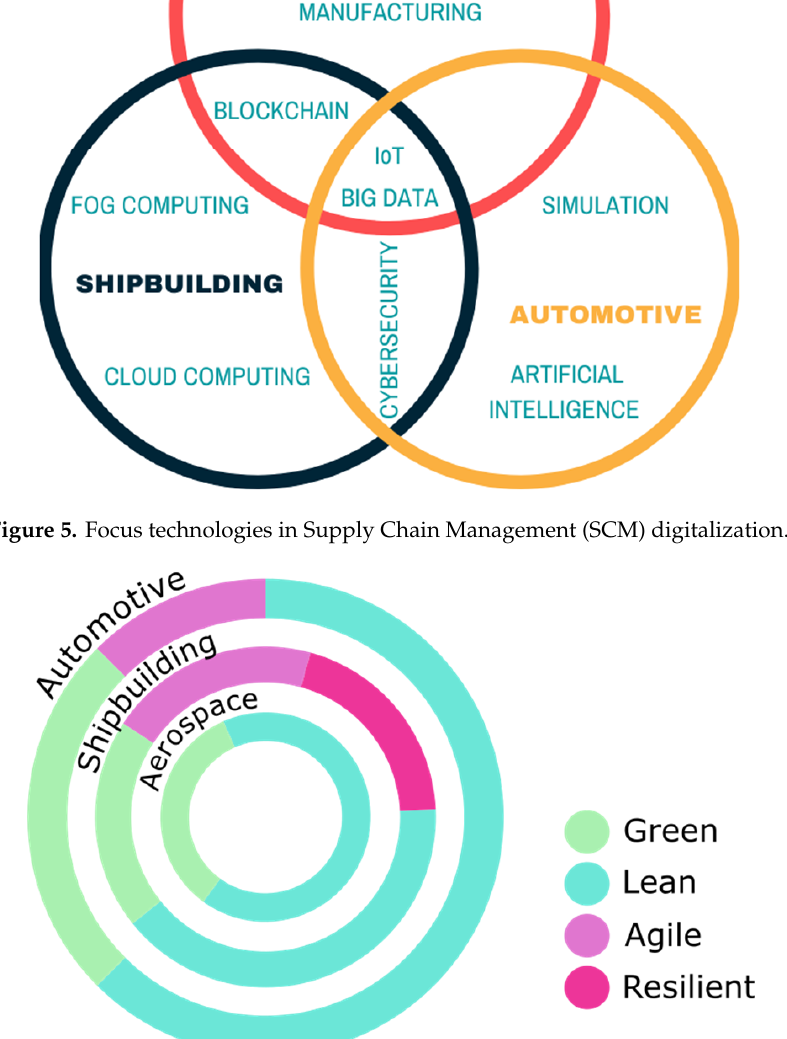
Figure 6. Sustainable Supply Chain-driving methodologies.